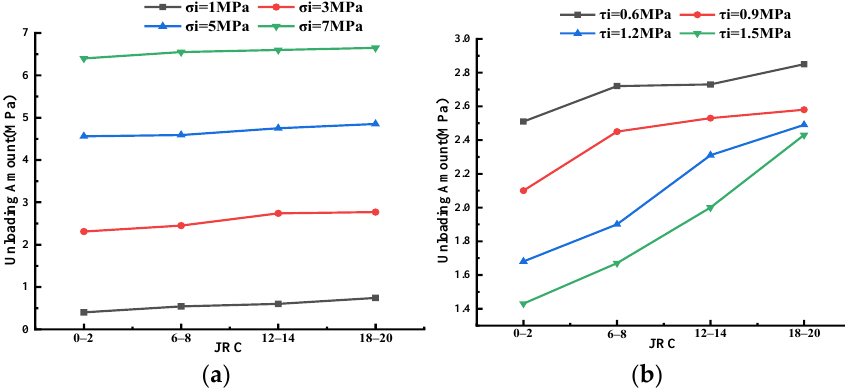
Figure 14. Unloading amount and roughness. ( a ) Group A. ( b ) Group B.